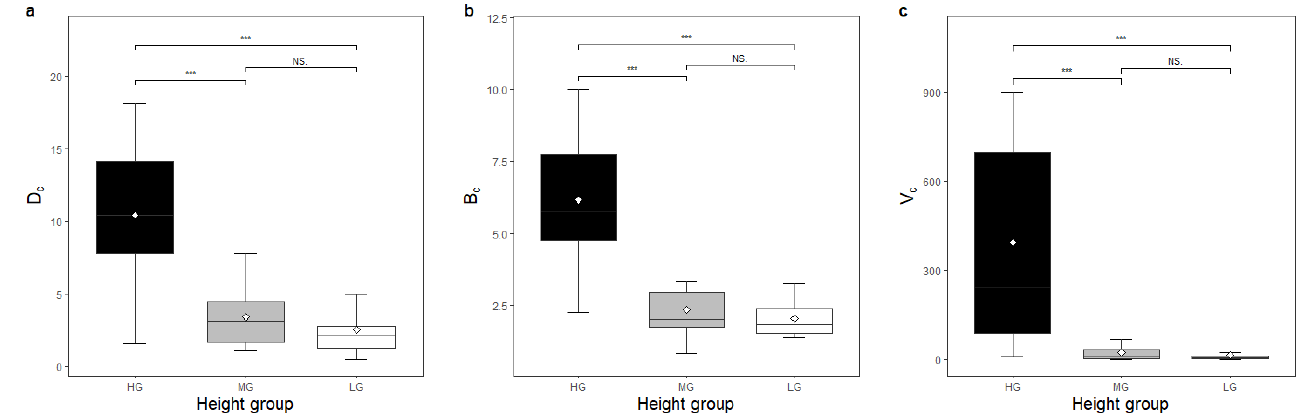
Figure 4. Canopy trait differences among height groups. Differences in each trait were checked using the Tukey test at a 95% family − wise confidence level. HG refers to the higher height group, comprising Machilus breviflora , Schima superba , and Castanopsis chinensis; MG refers to the middle height group, comprising Cryptocarya concinna and Cr . chinensis; LG refers to the lower height group, comprising Ca. fissa and M . chinensis . Black box represents HG, grey box represents MG and white box represents LG in ( a – c ). D c : crown depth; B c : crown breadth; V c : crown volume. *** p < 0.001;